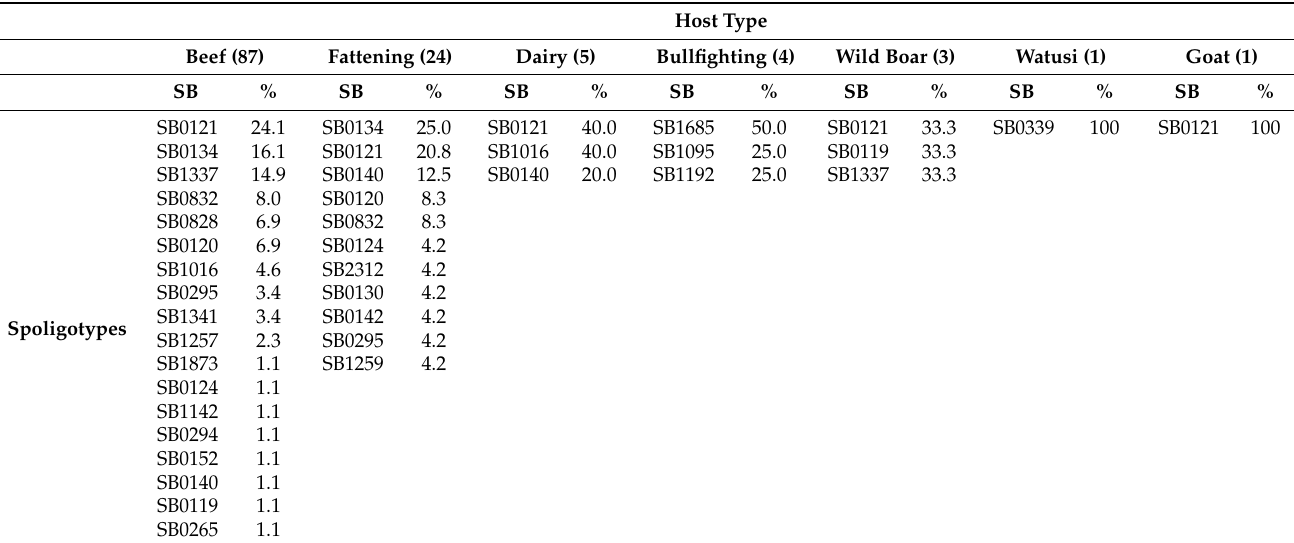
Table 1. M. bovis spoligotypes (SB) identified from different host types in Catalonia, Spain. Numbers in parentheses correspond to the total number of isolates from each host type. Proportion of isolates for each spoligotype is shown as a percentage (%) of the total number of isolates for that host type.